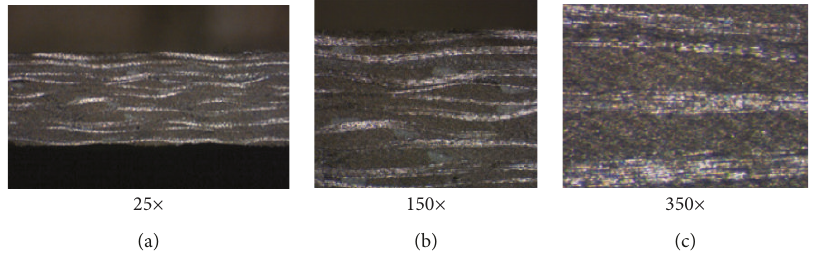
Figure 9: Inspection with an optical